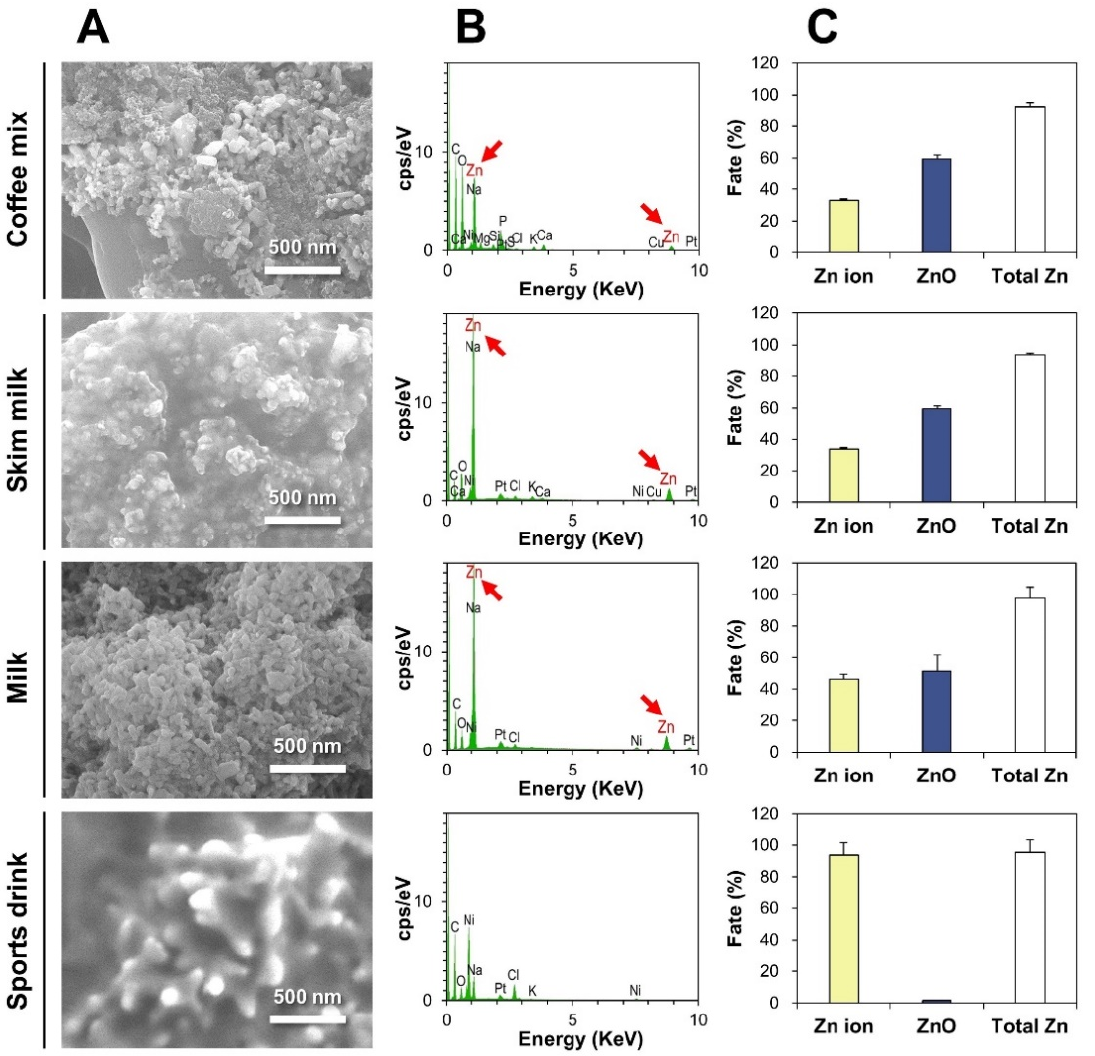
Figure 4. ( A ) FE-SEM images and ( B ) energy dispersive X-ray spectroscopy (EDS) analysis of the precipitates of ZnO-NP-spiked foods after CPE. ( C ) Fate (%) of ZnO NPs in ZnO-NP-spiked foods by CPE, followed by inductively coupled plasma–atomic emission spectroscopy (ICP-AES) quantification.